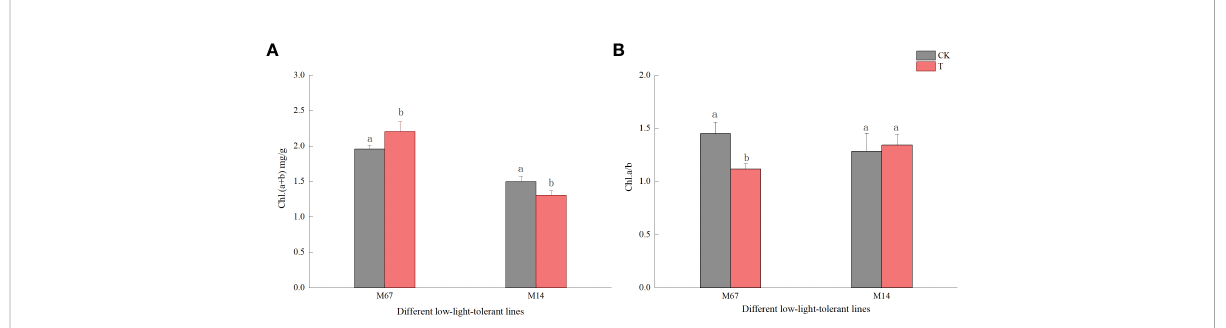
FIGURE 6 Effect on chlorophyll content in leaf of low light in different cucumber lines. (A) Chl (a+b) content and (B) Chl a/b of leaf in different cucumber lines. Lowercase letters a and b after the value represent statistically signi fi cant differences (p < 0.05) within a variety under different low-light treatments as determined by the least signi fi cant difference